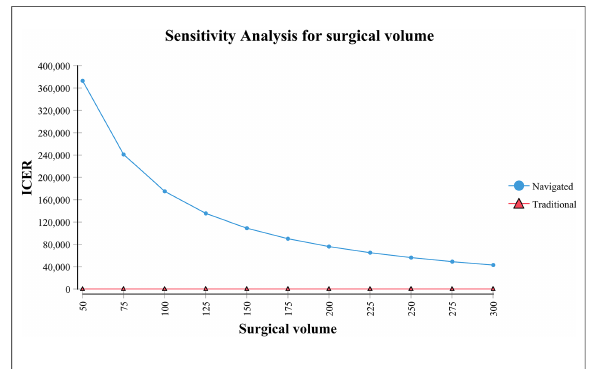
FIGURE 2 Sensitivity analysis re fl ected an inverse relationship between annual surgical volume of navigated surgery and incremental cost- effectiveness ratio